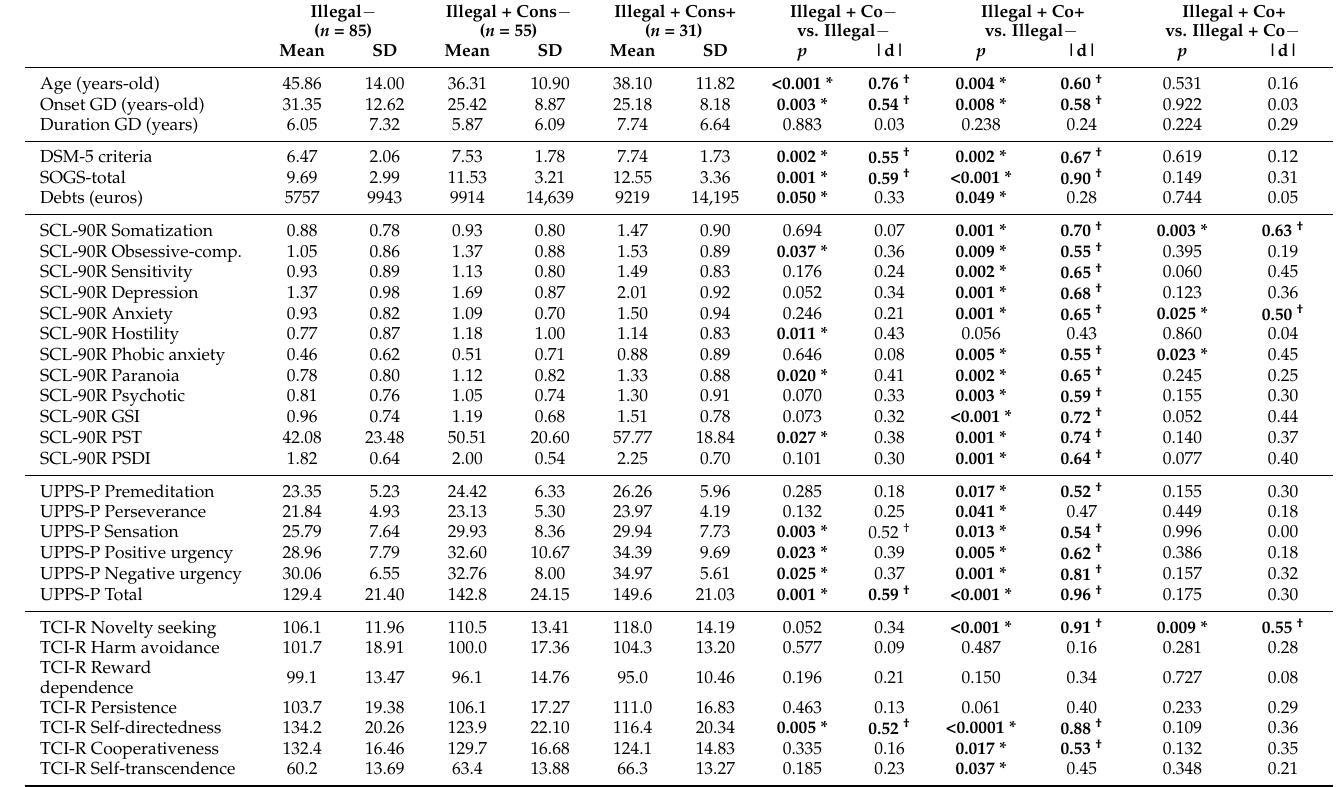
Table 2. Comparison between the groups for clinical profiles.